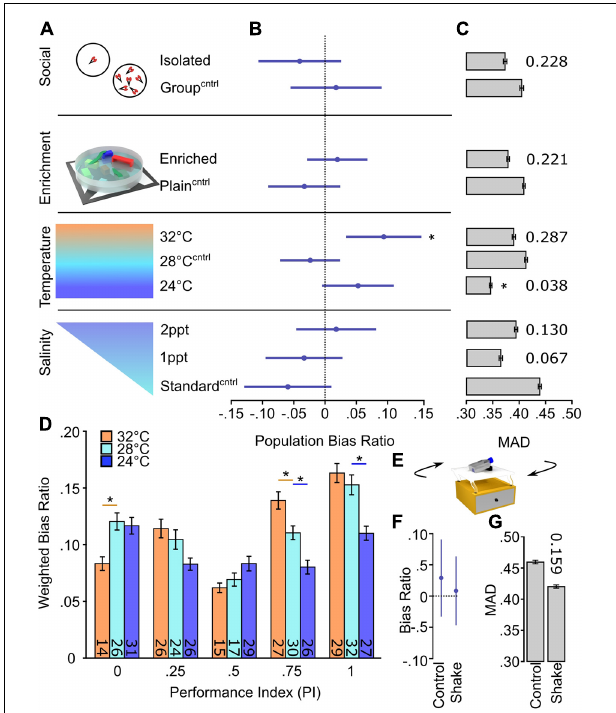
FIGURE 3 | Temperature selectively changes inter-individual variation in turn bias. (A) Schematic of environmental manipulations (Social Isolated N = 87, Social Group N = 87; Enriched N = 172, Plain N = 134; Temp. 32 ◦ C N = 112, Temp. 28 ◦ C N = 136, Temp. 24 ◦ C N = 144; Standard salinity N = 102, 1 ppt N = 107, 2 ppt N = 107). Each condition has an independent control denoted by superscript Cntrl. (B) Average bias ratios across the entire tested population per condition. Statistical comparison performed to 0, denoting no population level bias. (C) MAD for dark responses, error bars are 95% confidence levels generated from 1,000 bootstraps. Individual p -values shown above bars, calculated by comparing experimental groups to controls. (D) Average bias ratio per PI weighted by the percent of individuals. N ’s indicated within bars. (E) Representative diagram of the setup used to shake larvae during early development. Average population bias ratio (F) and MAD (G) between shake experiments. Number above bar represents p -value compared to the control group. Asterisk p <